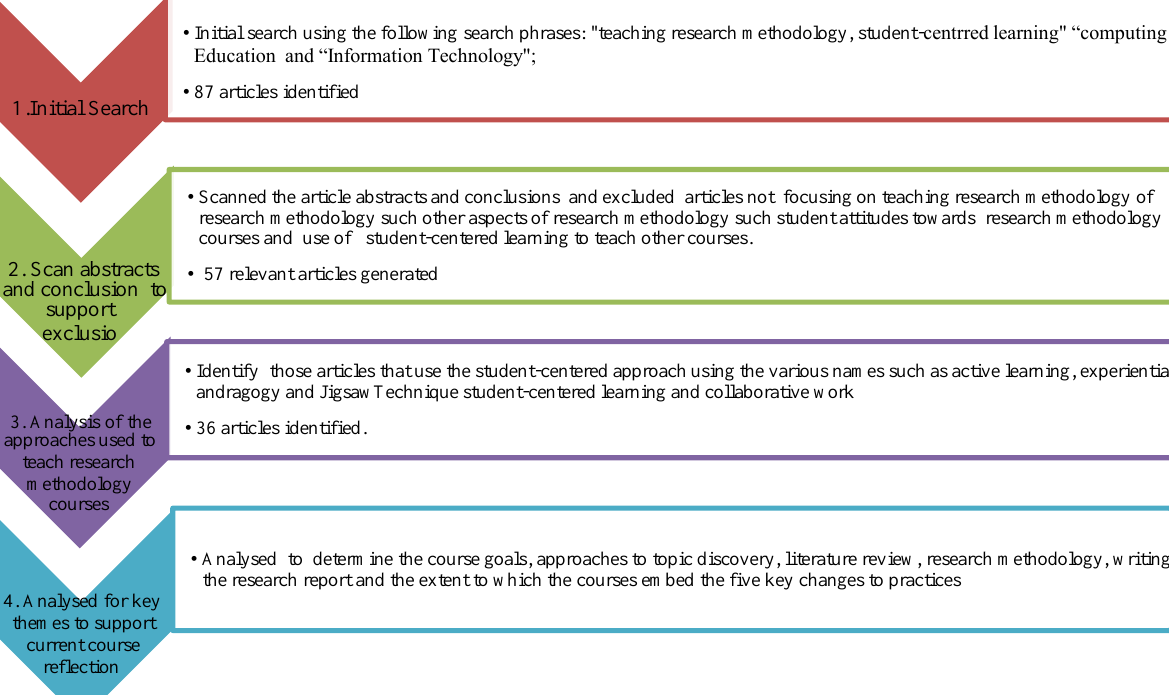
Figure 2. Flowchart of the research